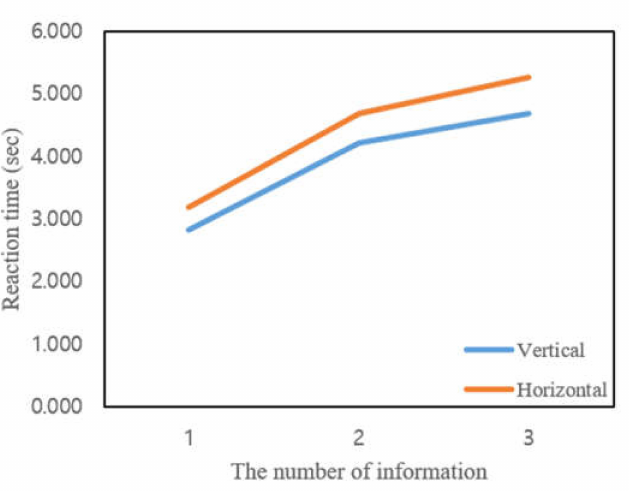
Figure 8. Reaction time according to the level of the number of information and arrangement of HUD.